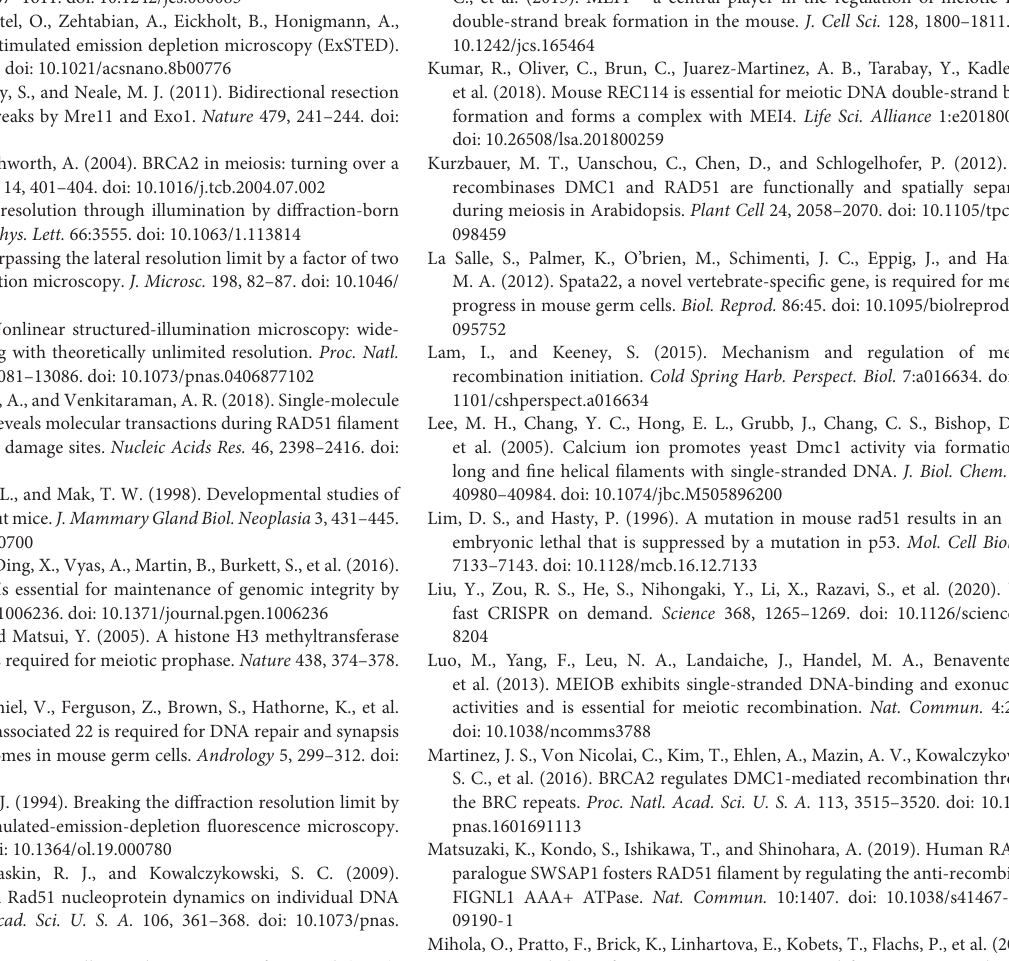
FIGNL1 AAA+ ATPase. Nat. Commun. 10:1407. doi: 10.1038/s41467-019-